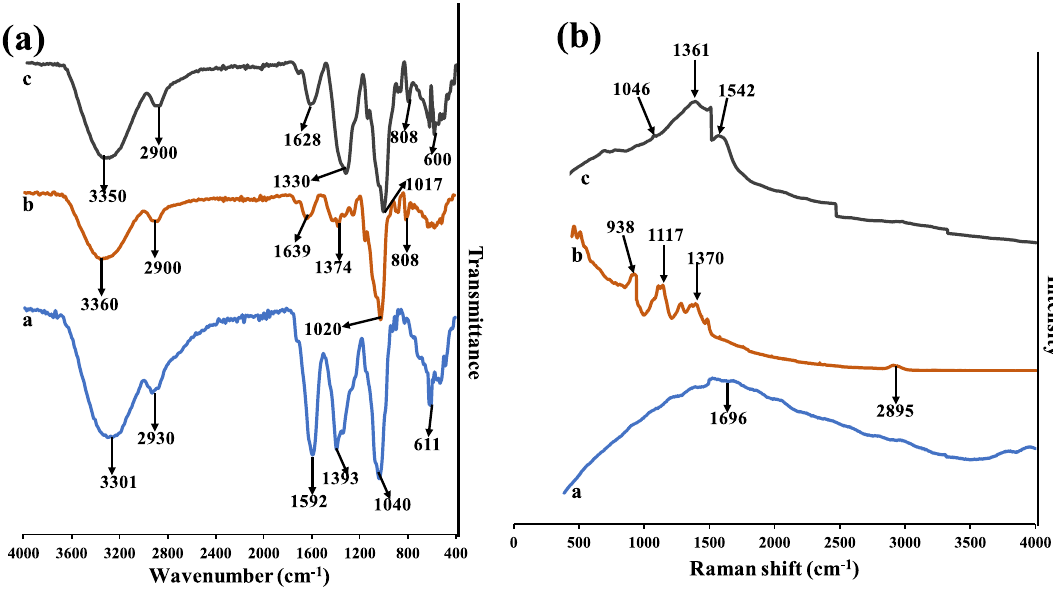
Figure 4. ( a ) FTIR spectra and ( b ) Raman spectra of ( a ) AGPE ( b ) KgM c